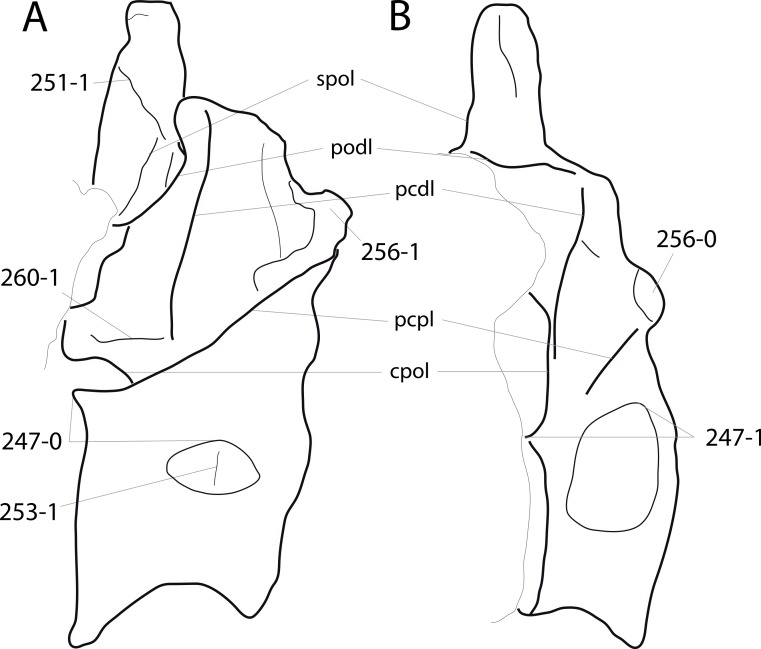
Diplodocine mid-dorsal vertebrae.Mid-dorsal vertebrae of “Dinheirosaurus” lourinhanensis ML 414 (A) and Galeamopus sp. SMA 0011 (B) in lateral view. Note the pleurocoels that are entirely situated on the centrum (A; C247-0), or invade the neural arch (B; C247-1), the accessory spinal lamina connecting to the junction of spol and spdl (A; C251-1), the vertical lamina subdividing the pleurocoel (A; C253-1), the anteriorly displaced parapophysis (A; C256-1) in contrast to its usual position above the anterior edge (B; C256-0), and the horizontal accessory lamina connecting the hyposphene with the pcdl (A; C260-1). Abb.: cpol, centropostzygapophyseal lamina; pcdl, posterior centrodiapophyseal lamina; pcpl, posterior centroparapophyseal lamina; podl, postzygodiapophyseal lamina; spol, spinopostzygapophyseal lamina. Scaled to same vertebral height.